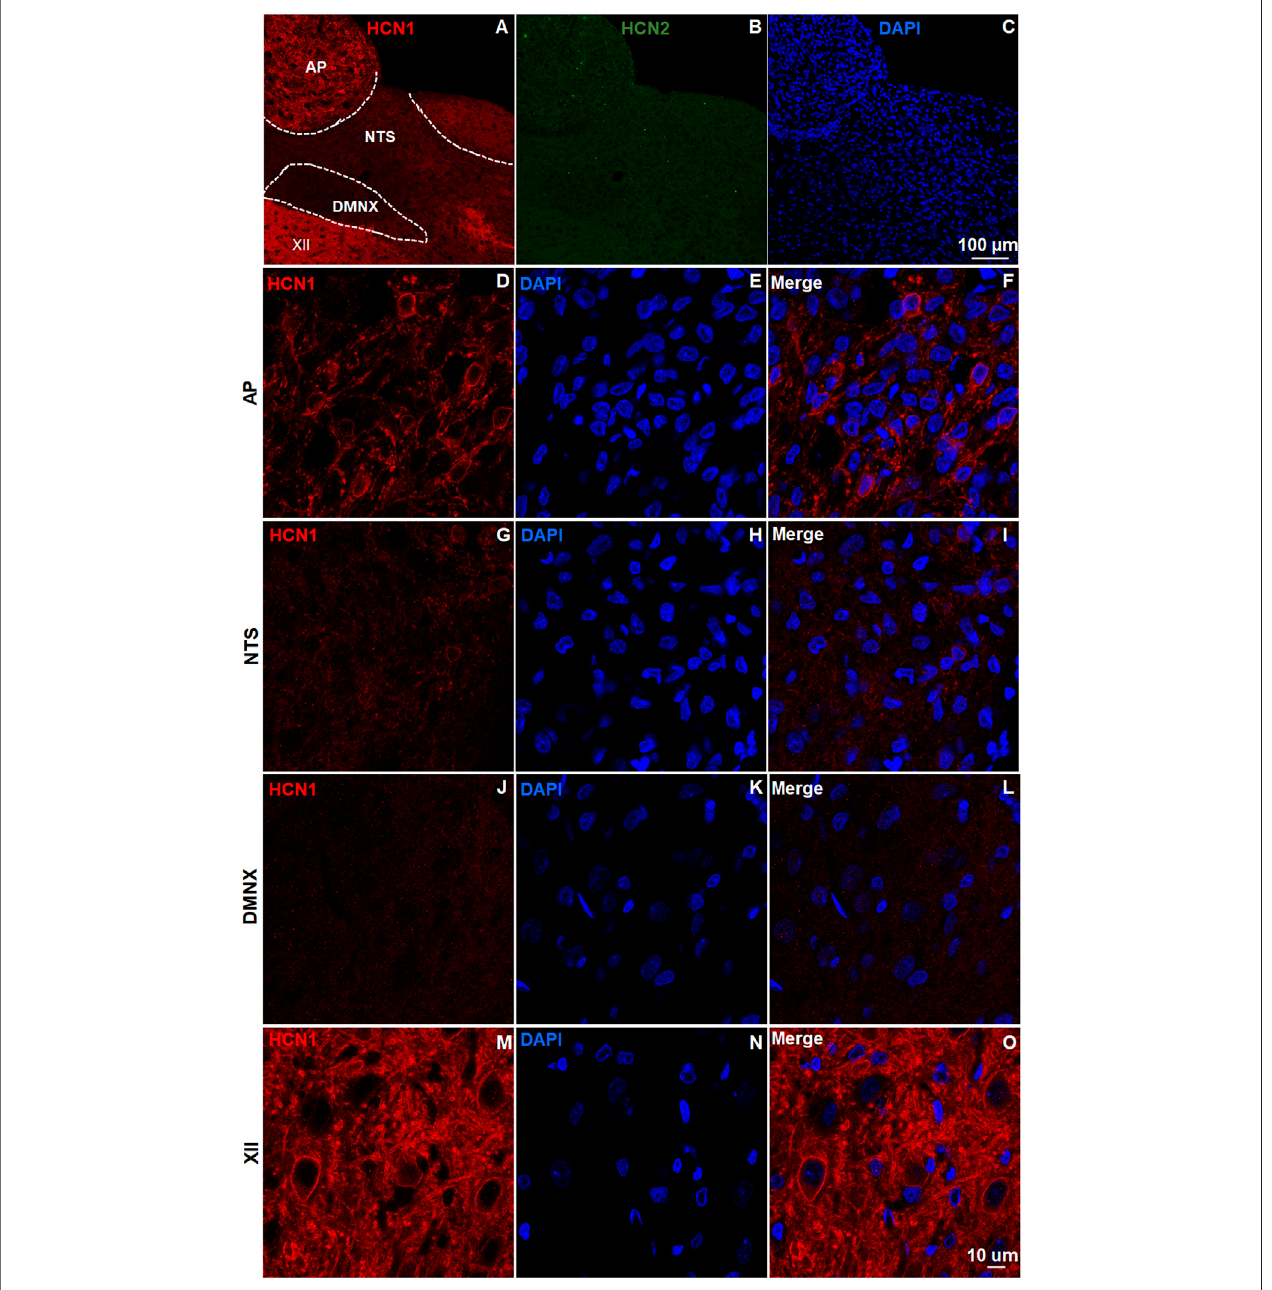
FIGURE1| ExpressionofHCNchannelsubtypes1and2.HCNchannelimmunostainingwithrabbitanti-HCN1andmouseanti-HCN2primaryantibodiesfollowed by Alexa Fluor 594 donkey anti-rabbit and 488 donkey anti-mouse secondary antibodies were performed on coronal brainstem sections (20 μ m) prepared from naïve least shrews ( n (cid:2) 3 shrews). Nuclei were stained with DAPI in blue. (A-C) Representative images (20x) show expression of HCN1 but not HCN2 observed in the least shrew brainstem dorsal vagal complex (DVC) area including the three emetic nuclei, the area postrema (AP), the nucleus tractus solitarius (NTS) and the dorsal motornucleusofthevagus(DMNX).Scalebar,100 µm.(D – O)Representativeimages(60x)showdifferentialexpressionofHCN1observedintheareapostrema(AP),the nucleus tractus solitarius (NTS), the dorsal motor nucleus of the vagus (DMNX) and the hypoglossal nuclei (XII). Scale bar, 50